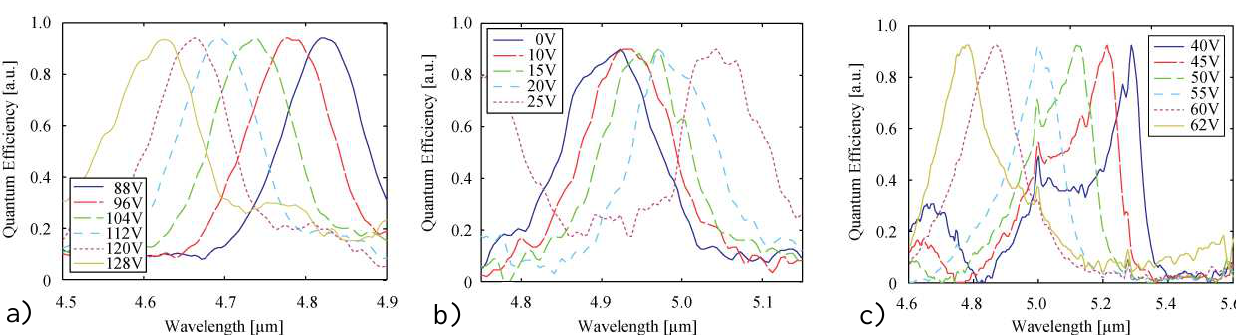
Figure 10: Measured spectral responses for micromirrors actuated with (a) piezoelectric actuators, (b) parallel plate electrostatic actuators, and (c) comb drive actuators